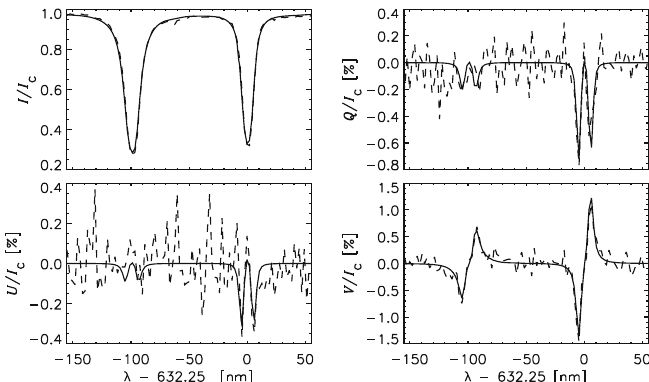
Fig. 2 Example of Stokes profiles observed with the Hinode spectropolarimeter in a quiet Sun IN region. Note the prominent Stokes Q and U signals exhibited by the Fe i 630.25 nm line. The dashed lines represent thebest-fitprofilesusingasimpleMilne–Eddingtonmodelatmospherewithahomogeneousmagneticfield. The observations are well reproduced by a field of 177 G which is inclined 107 ◦ to the local vertical and occupies 42% of the pixel. Image reproduced with permission from Orozco Suárez et al. (2007b), copyright by